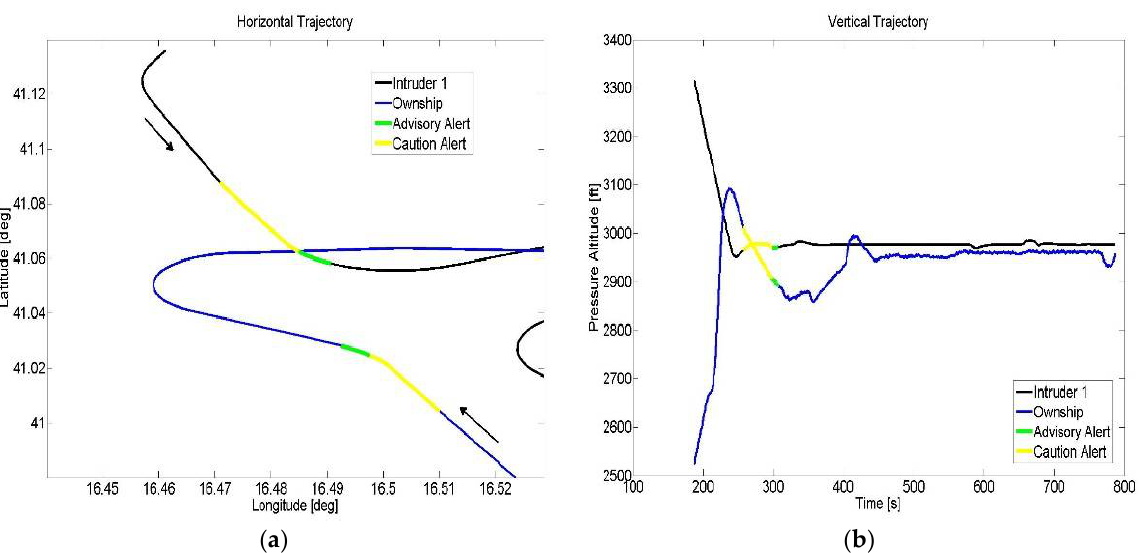
Figure 16. ( a ) Horizontal trajectory of the encounter. After the activation of the Caution alert the RP receives a clearance from the controller to execute a left turn maneuver that solves the encounter. ( b ) Vertical trajectory of the encounter. The RPAS is descending while the intruder is in level flight during the RWC alert activations. No vertical maneuver is executed by either aircraft involved during the encounter.